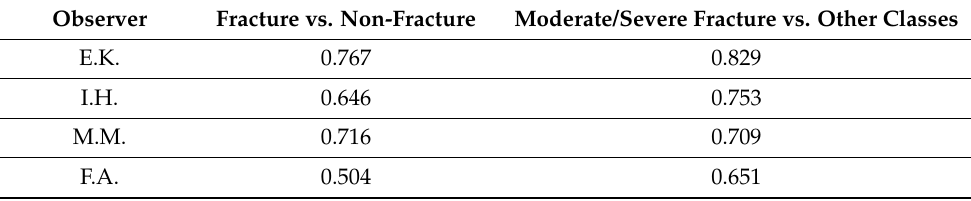
Table 4. Inter-rater agreement (Cohen’s kappa) for each observer compared to the gold standard, for the diagnosis of mild, moderate, and severe fractures vs. non-fractured vertebrae (normal or non-fracture